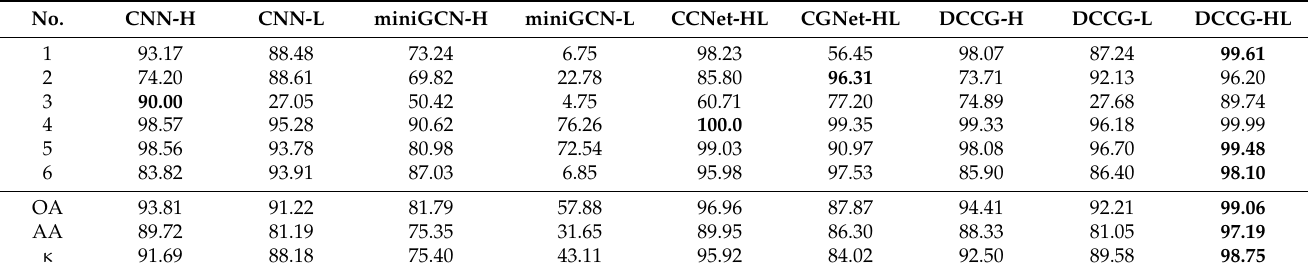
Table 3. Per-class accuracy, OA, AA and κ obtained by different methods on Trento data. The bold text in each row indicates the best classification